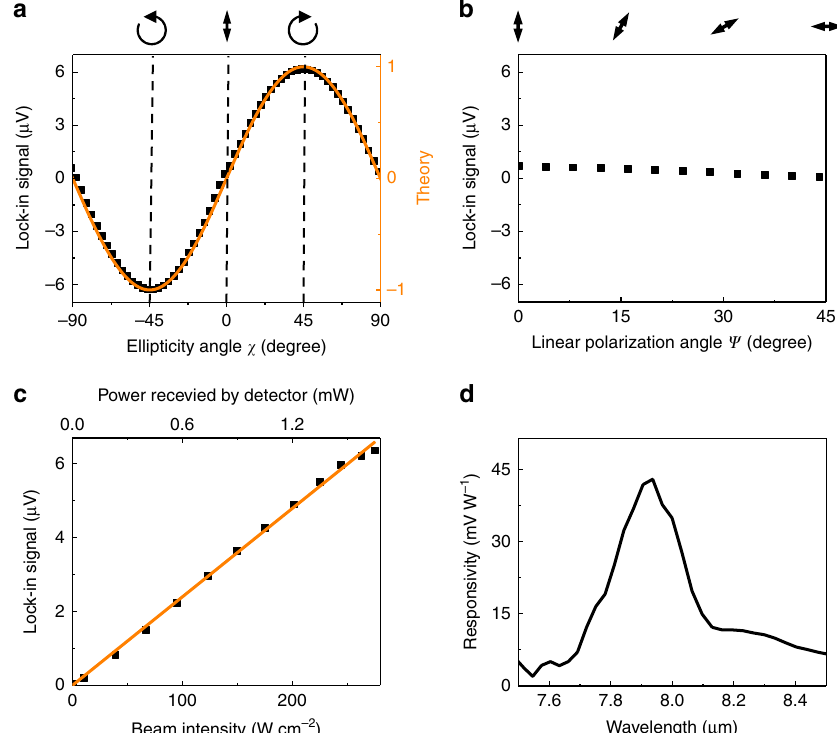
Figure 4 | Device characterization. ( a ) Measured thermopile emf voltage (black dots) as a function of the ellipticity angle w of incident light at l ¼ 7.9 m m and 270Wcm (cid:2) 2 intensity, in comparison with the normalized S 3 Stokes parameter (orange curve). The ellipticity angle w at (cid:2) 45 (cid:2) , 0 (cid:2) and 45 (cid:2) correspond to LCP, linear and RCP light, respectively. ( b ) Measured emf voltage for the linearly polarized light at different polarization directions. Measurements are performed under the same conditions as in a . ( c ) The dependence of emf voltage on the light intensity for RCP illumination at l ¼ 7.9 m m. ( d ) Measured spectral dependence of the responsivity of the thermopile detector for RCP light